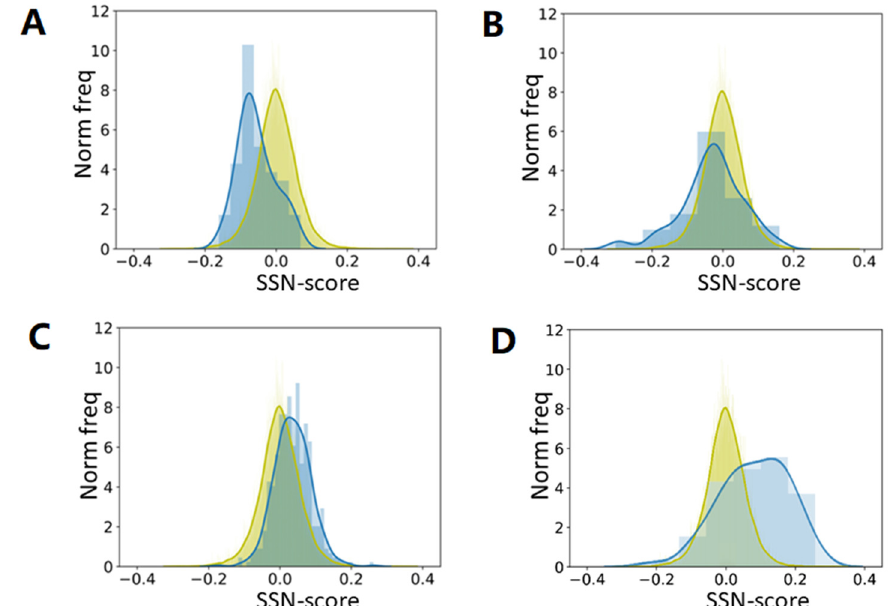
Figure 6. Normality scores for four classes of proteins determined using SSN scores obtained from a large, representative dataset. The green histogram is for all 22,405 proteins in the dataset, the blue histogram is for the subset. The axes are similar as in Figure 4. ( A ) The blue histogram is for 79 files with “hemoglobin” in the text. ( B ) 65 proteins with “finger” in the text (mostly zinc-finger or ring-finger). ( C ) 387 proteins with “thermophiles” in the text. ( D ) 66 proteins with “de novo” in the text.